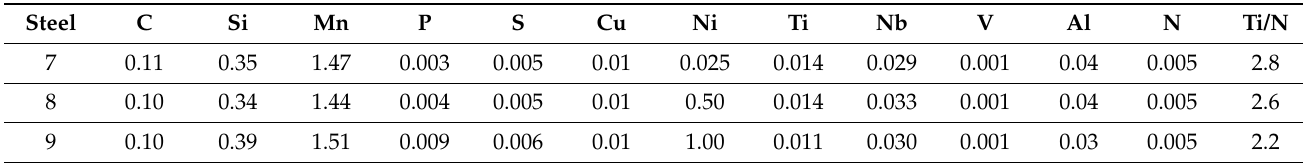
Table 2. Composition of Ni containing HSLA steels, weight %